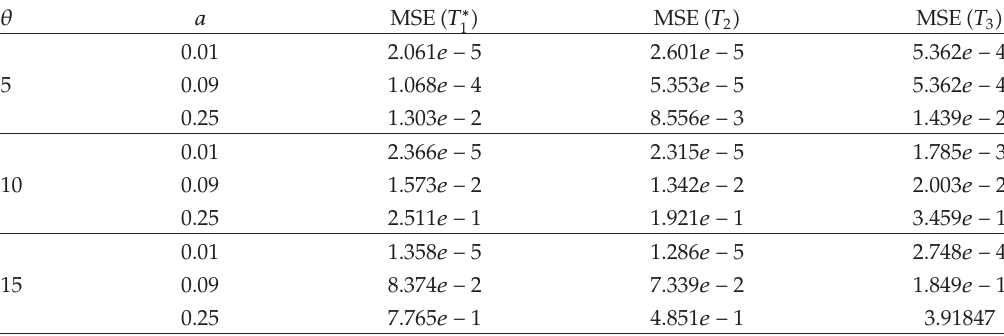
, T 2 , and T 3 when n (cid:5) 20. 1